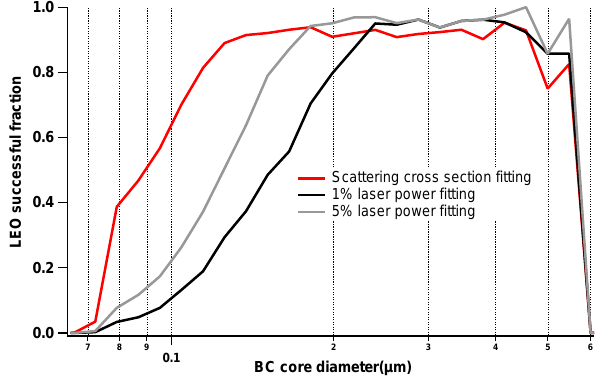
Figure B2. The LEO successful fraction as a function of BC core diameter for different LEO fitting